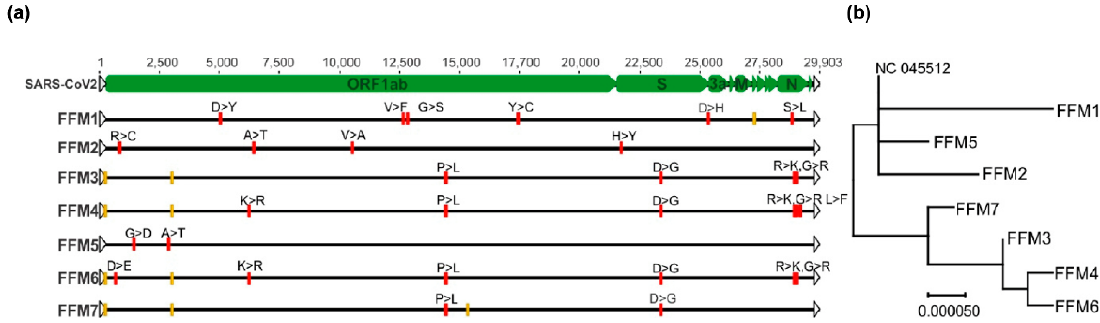
Figure 5. SARS-CoV-2 sequences are highly conserved in terms of the M-gene. ( a ) SARS-CoV-2 isolates FFM1–7 described in this study were mapped to the NC_045512 (SARS-CoV-2) reference genome using the Geneious Prime software. Single nucleotide polymorphisms and their corresponding positions are indicated as colored boxes. Amino acid substitutions are shown above red boxes. Silent mutations are indicated in yellow boxes. ( b ) Phylogenetic tree of SARS-CoV-2 isolates, inferred by using the Maximum Likelihood method and Tamura–Nei model using the MEGA-X software. The tree is drawn to scale, with branch lengths representing the number of substitutions per site.